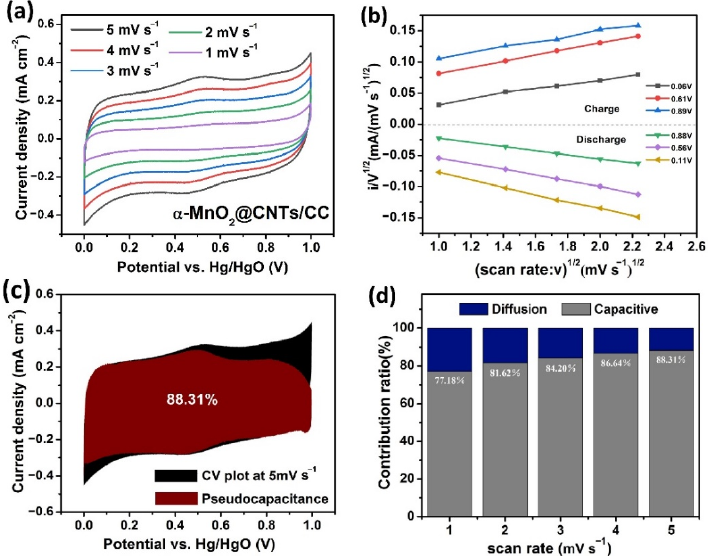
Figure 7. ( a ) CV curves of α -MnO2@CNTs/CC; ( b ) 6 selected sets of CV data obtained at different voltages for the calculation of k1 by Equation (4); ( c ) Pseudocapacitance of the α -MnO2@CNTs/CC electrode at 1 mV s − 1; ( d ) Pseudocapacitance contribution ratios.